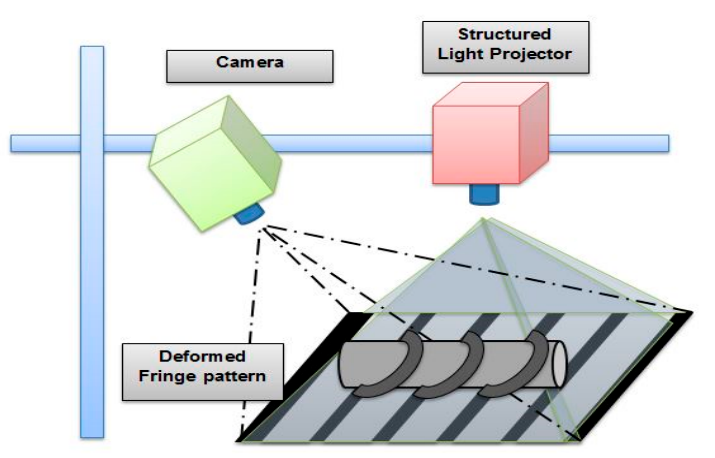
Figure 4. Fringe projection system.